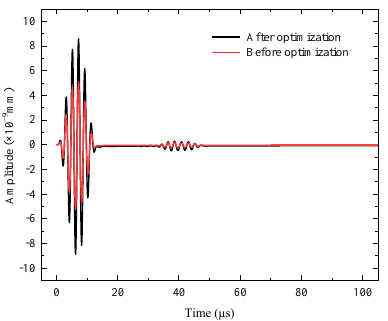
Figure 21. The influence of coil thickness on the amplitude of received signal.